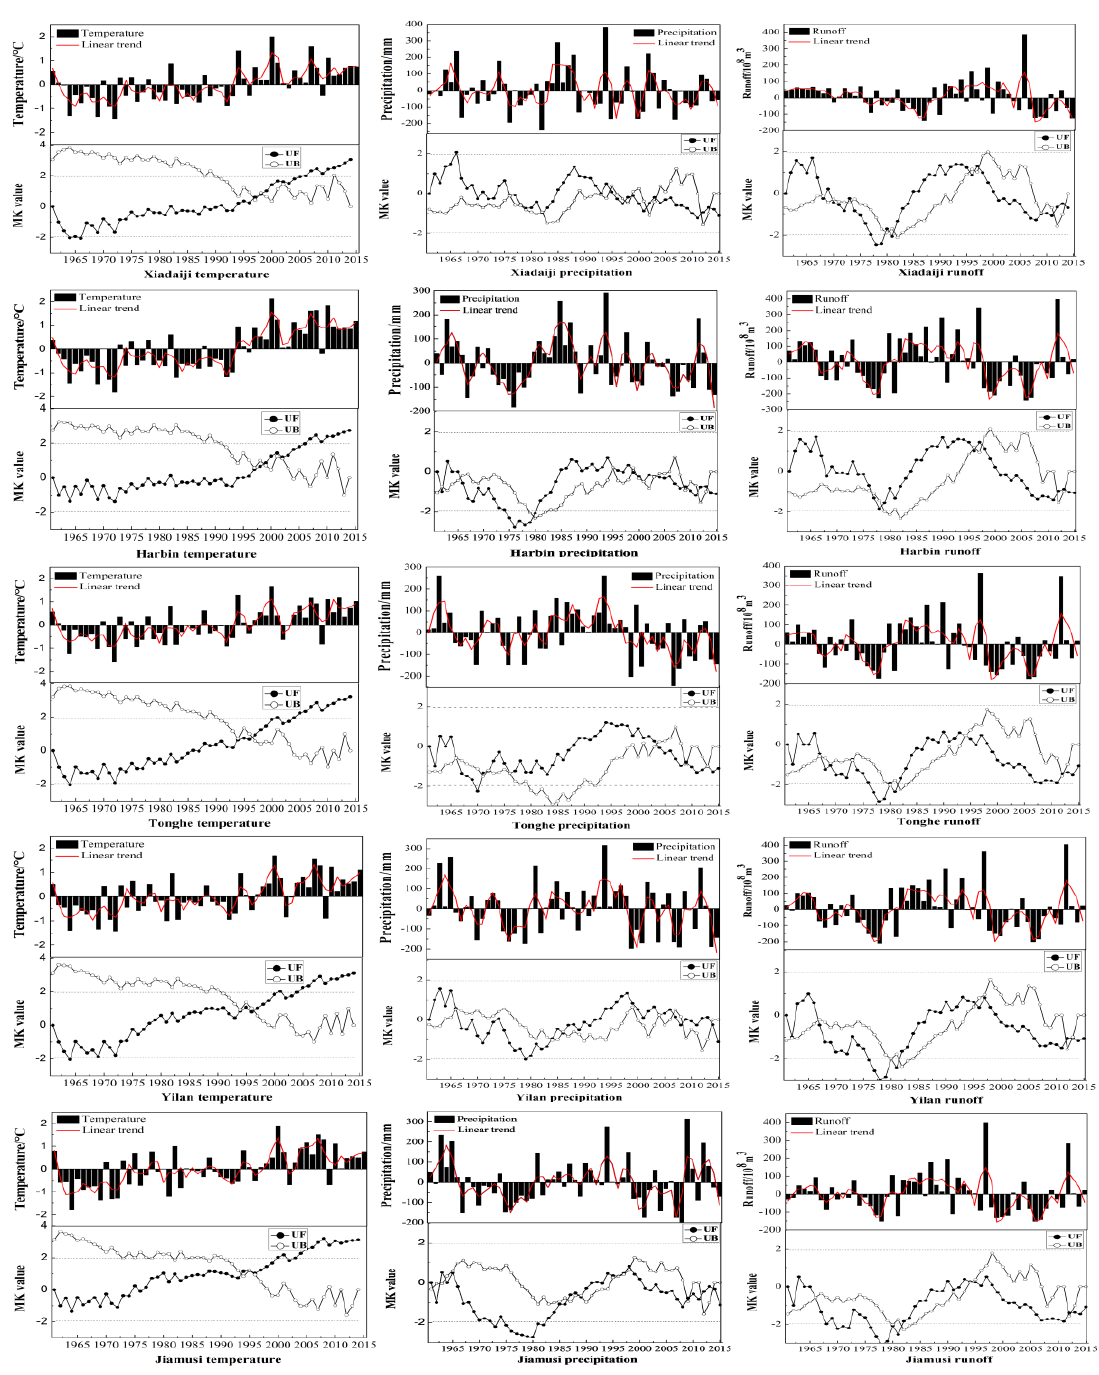
Figure 3. Variations and Manner-Kendall-Sneyers trend test of temperature, precipitation and runoff in the main stream of the Songhua